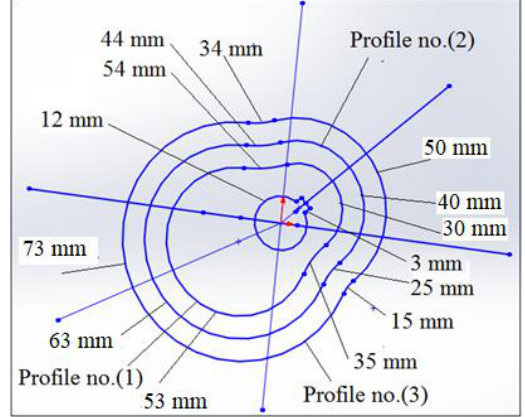
Figure 3. Three involutes’ profile of the cam with its dimension.